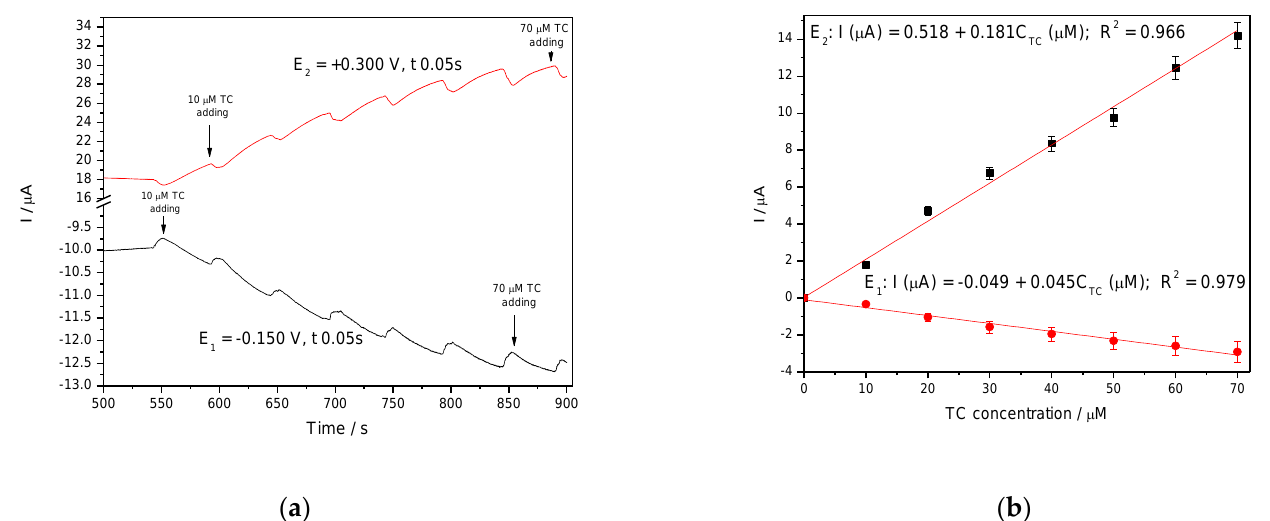
16 of 20 Figure 12. ( a ) Chronoamperometry(CA) recorded on Ag/GO/BDD electrode at the potential value of E 1 = − 0.150 V/SCE, E 2 = +0.030 V/SCE, E 3 = +0.300 V/SCE and E 4 = +0.500 V/SCE in 0.1 M NaOH supporting electrolyte and in the presence of 10 to 70 µM TC. ( b ) The calibration plots of the currents recorded at E